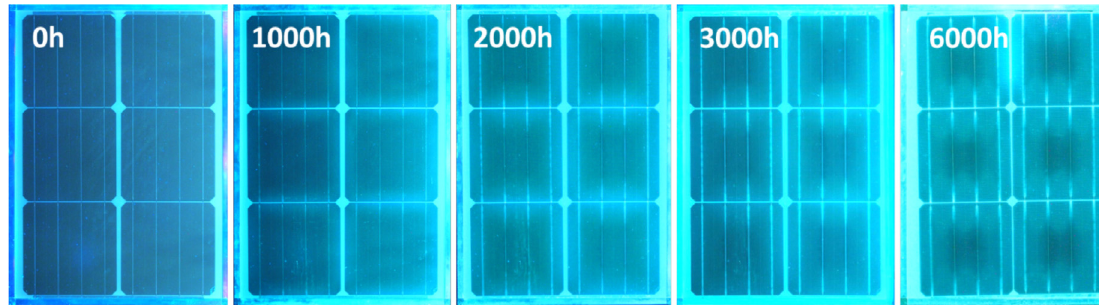
Fig. 3. UVF-images of the Tropical 1 time series.